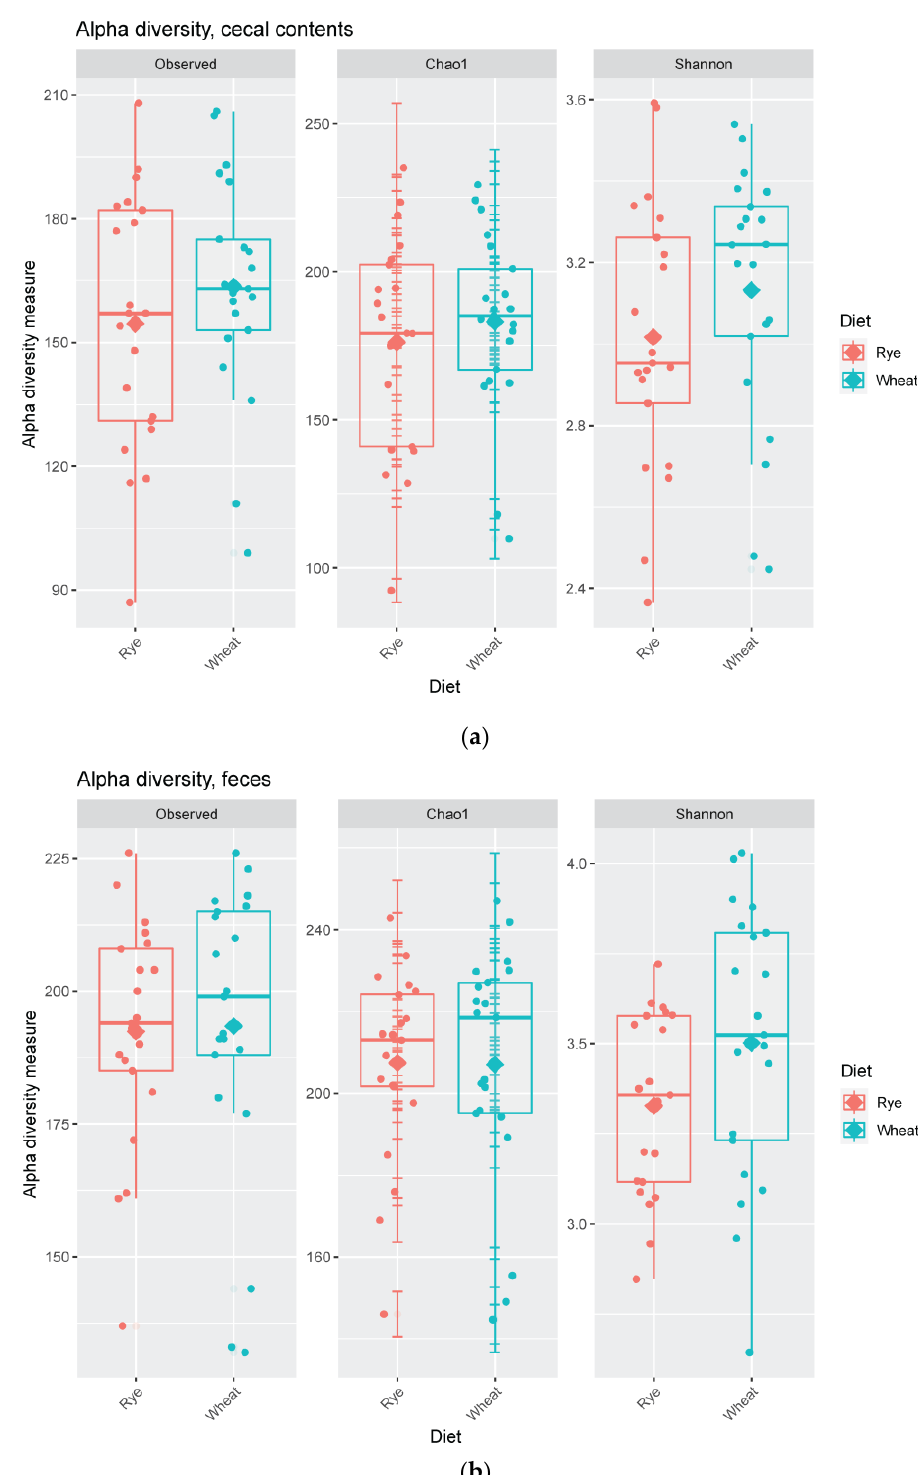
Figure 1. Boxplots showing Observed species, Chao1 and Shannon index in ( a ) cecal contents and ( b ) feces of pigs depending on diet.